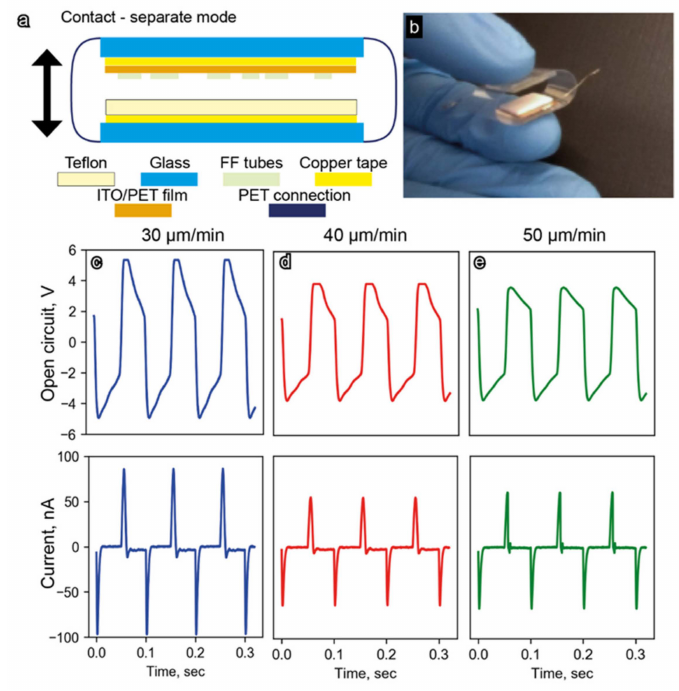
Figure 4. ( a ) Schematic of the developed FF-based TENG; ( b ) full-size image of the TENG prototype used for experimental testing. Output performance characteristics (open-circuit voltage and shortcut current) of the developed TENGs fabricated with FF microbelts grown with different pulling velocities: ( c ) 30 µ m/min, ( d ) 40 µ m/min, and ( e ) 50 µ